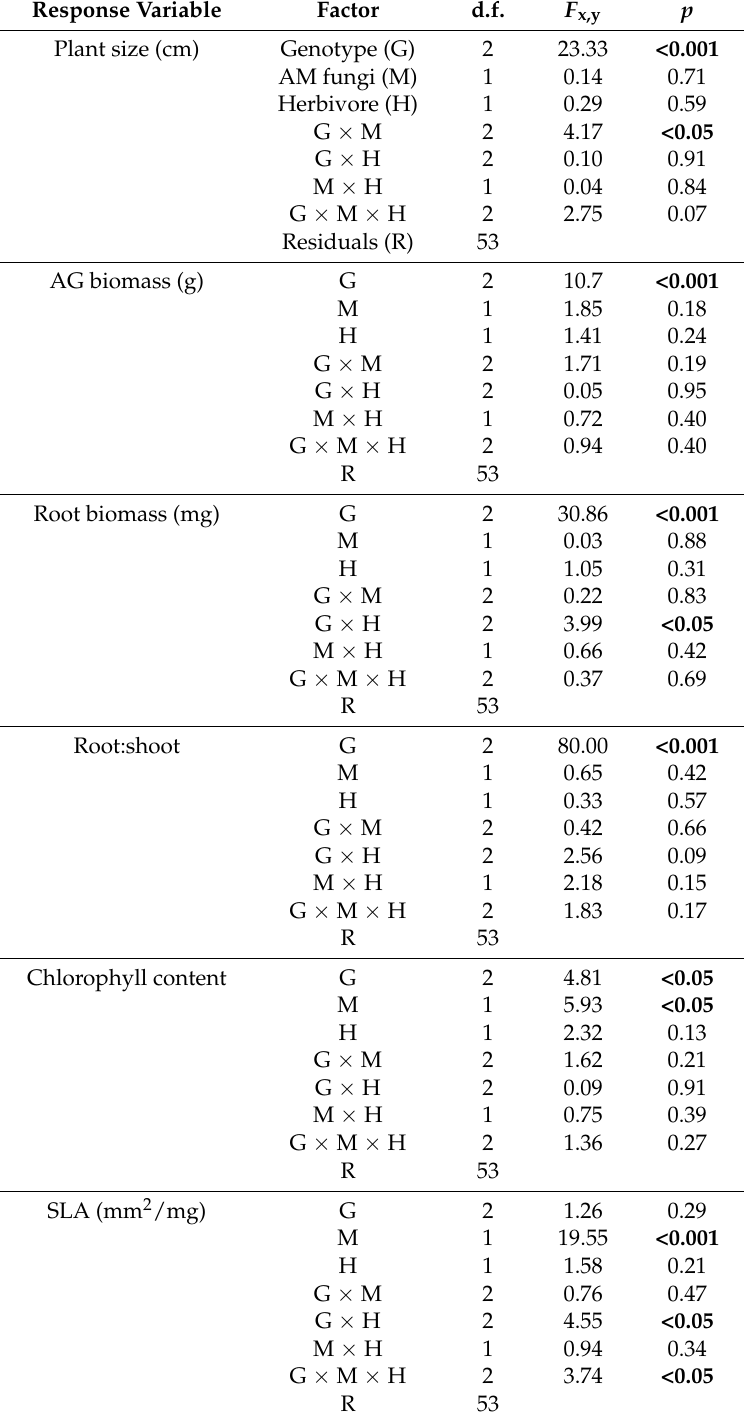
Table 1. Three-way interaction ANOVAs table on tomato plant growth and defense traits and two-way interaction ANOVA on AM-colonization of plant roots. Factors include (G) tomato plant type: JA expression deficient plants (def-1), wild-type (WT) plants, and JA constitutive expression plants (35S:: PS ); (M) inoculation or not with the AM fungus R. irregularis , (H) herbivory attack or not by S. littoralis caterpillar. Plant traits and root colonization were measured after eight weeks of plant growth. Bold indicate significant effect ( p <